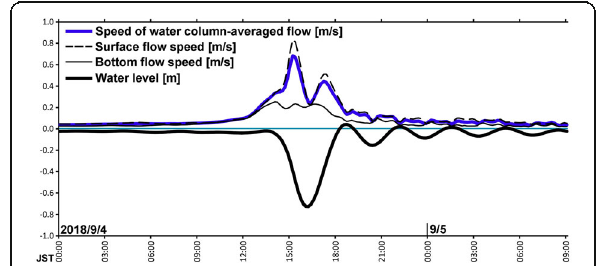
Fig. 13 Simulated time series of the water level (solid black line), the depth-averaged flow (solid blue line), the surface flow (dashed line), and the bottom flow speed (fine line) averaged over the area of the southern basin during the period from 0:00 JST on 4 September